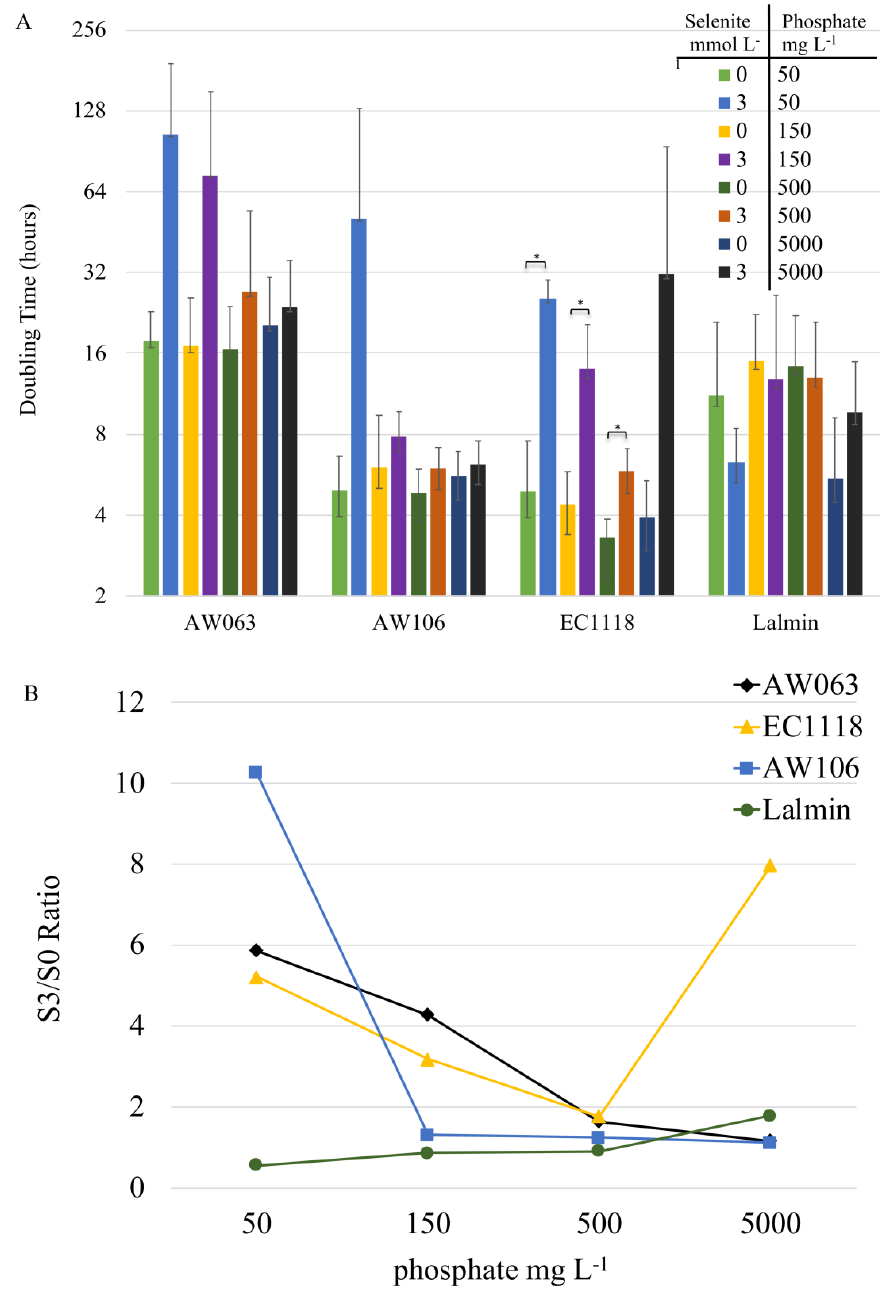
Figure 3. Growth rates of yeast strains in conditions of varying selenite and phosphate. Strains’ growth rate in the indicated amounts of sodium selenite or potassium phosphate was monitored for 48 h, and doubling time determined. ( A ) Doubling times are displayed on a logarithmic scale. ( B ) The S3/S0 ratio was determined by dividing the doubling time of the strain in 3 mmol L −1 selenite by the doubling time of the strain in 0 mmol L −1 selenite. Yeast strains are represented as EC1118 ( ▲ ), AW106 ( ■ ), Lalmin ( ● ), and AW063 ( ♦ ). Bar with asterisk indicates a significant difference ( p < 0.05) in doubling time between 0 and 3 mmol L −1 conditions.